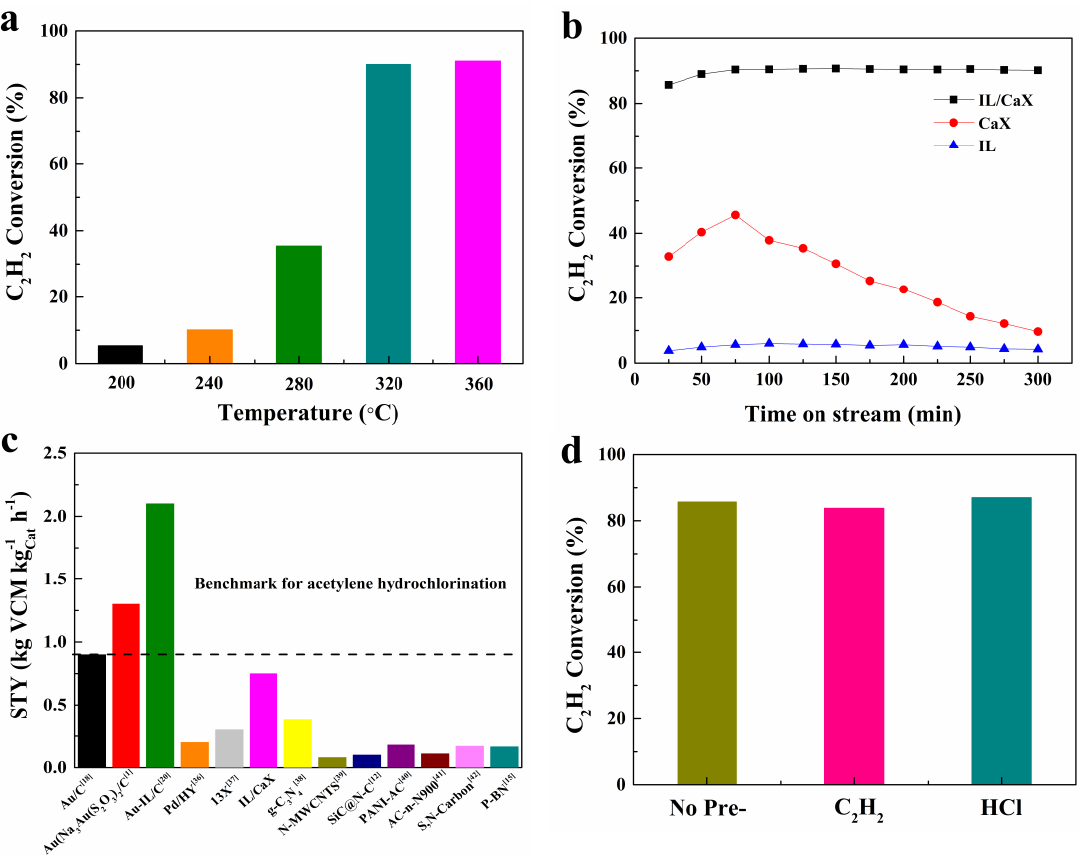
Figure 5. Catalytic performance as functions of different parameters: ( a ) Reaction temperature of IL/CaX; ( b ) Different catalysts. Reaction conditions: IL/CaX, 320 ◦ C, GHSV(C 2 H 2 ) = 100 h − 1 ; V(HCl)/V(C 2 H 2 ) = 1.2; CaX, 320 ◦ C, GHSV(C 2 H 2 ) = 20 h − 1 ; V(HCl)/V(C 2 H 2 ) = 1.2; IL, 320 ◦ C, GHSV(C 2 H 2 ) = 20 h − 1 ; and V(HCl)/V(C 2 H 2 ) = 1.2; ( c ) Space-time yield of VCM, STY(VCM),